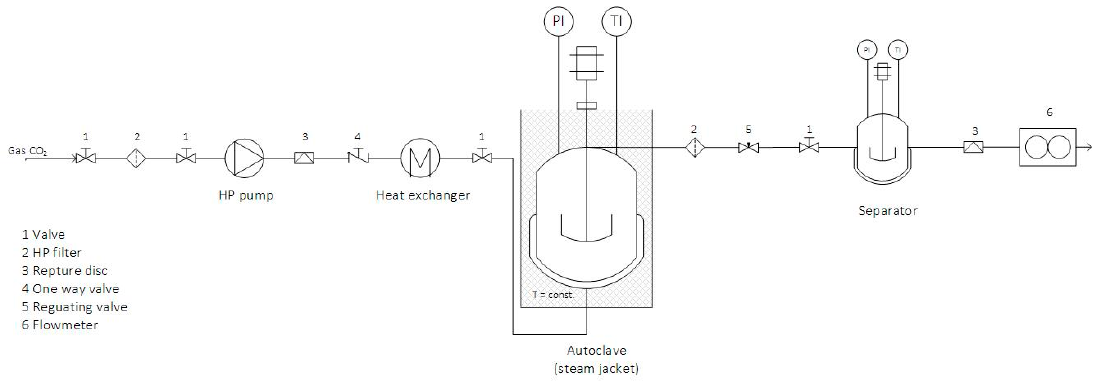
Figure 7. Supercritical fluid extraction system.